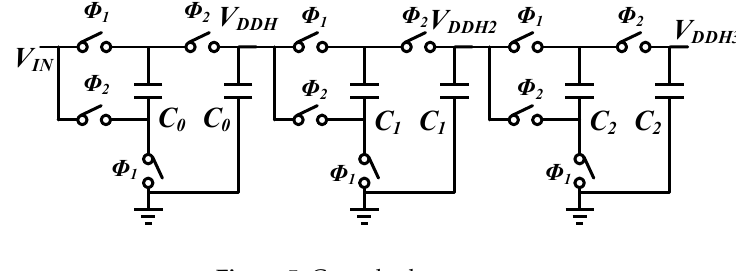
Figure 5. Cascade charge pump.